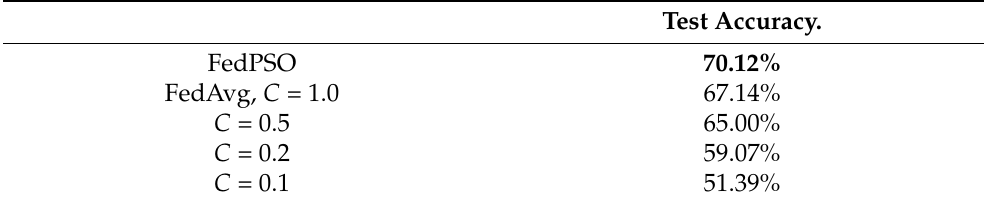
Table 3. Test Accuracy.